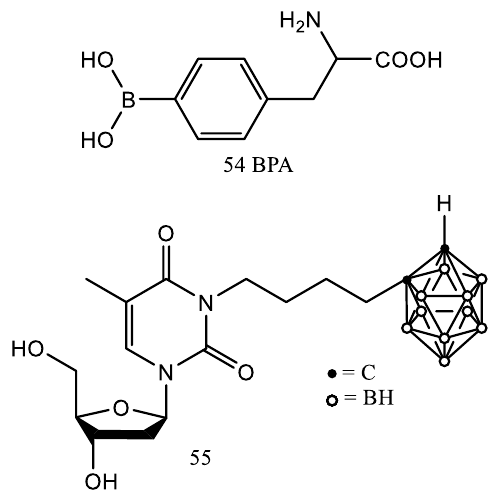
Figure 16. Chemical structures of boronophenylalanine and boronated nucleoside 55 ,